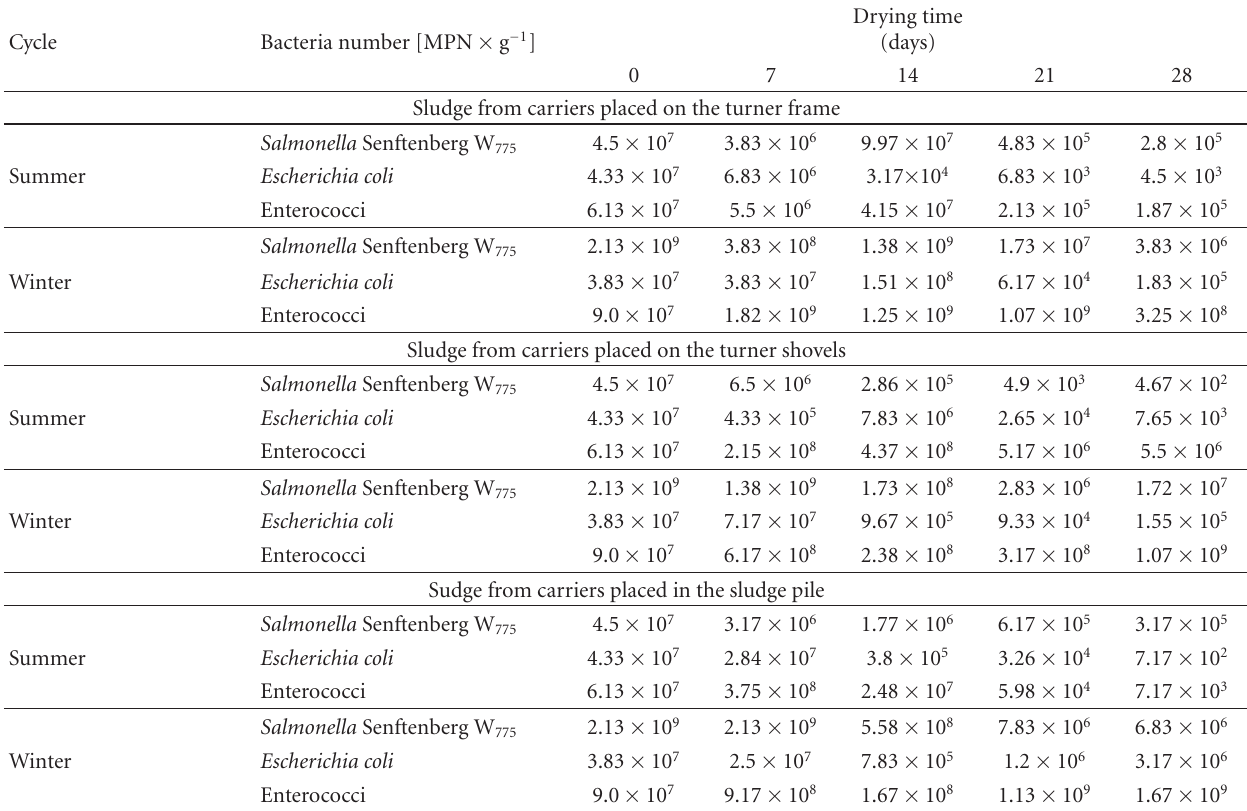
Table 4: Number of indicator bacteria in particular determination times.